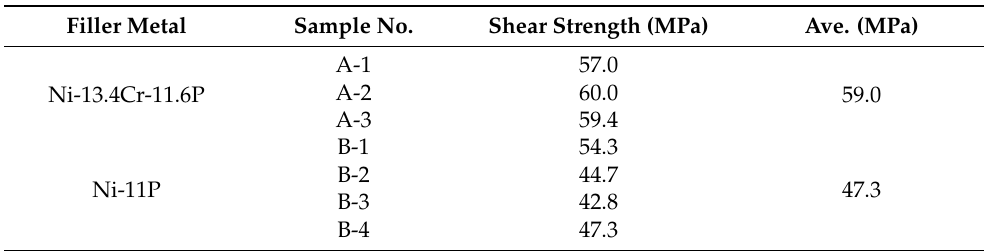
Table 4. Shear strength of joints brazed with electrodeposited Ni-13.4Cr-11.6P alloy coating and electrodeposited Ni-11P alloy coating